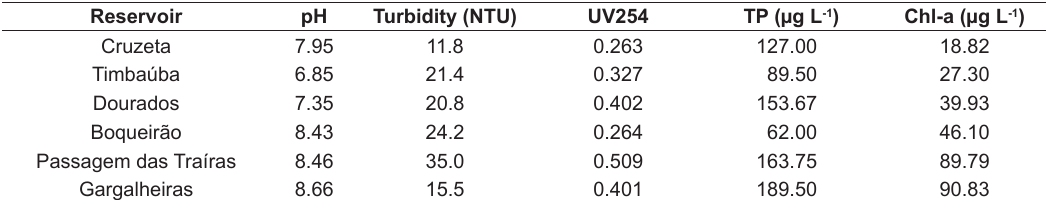
Table 2. pH, Turbidity, absorbance at UV 254 nm, total phosphorus (TP) and chlorophyll- a concentrations in raw water used for jar tests.